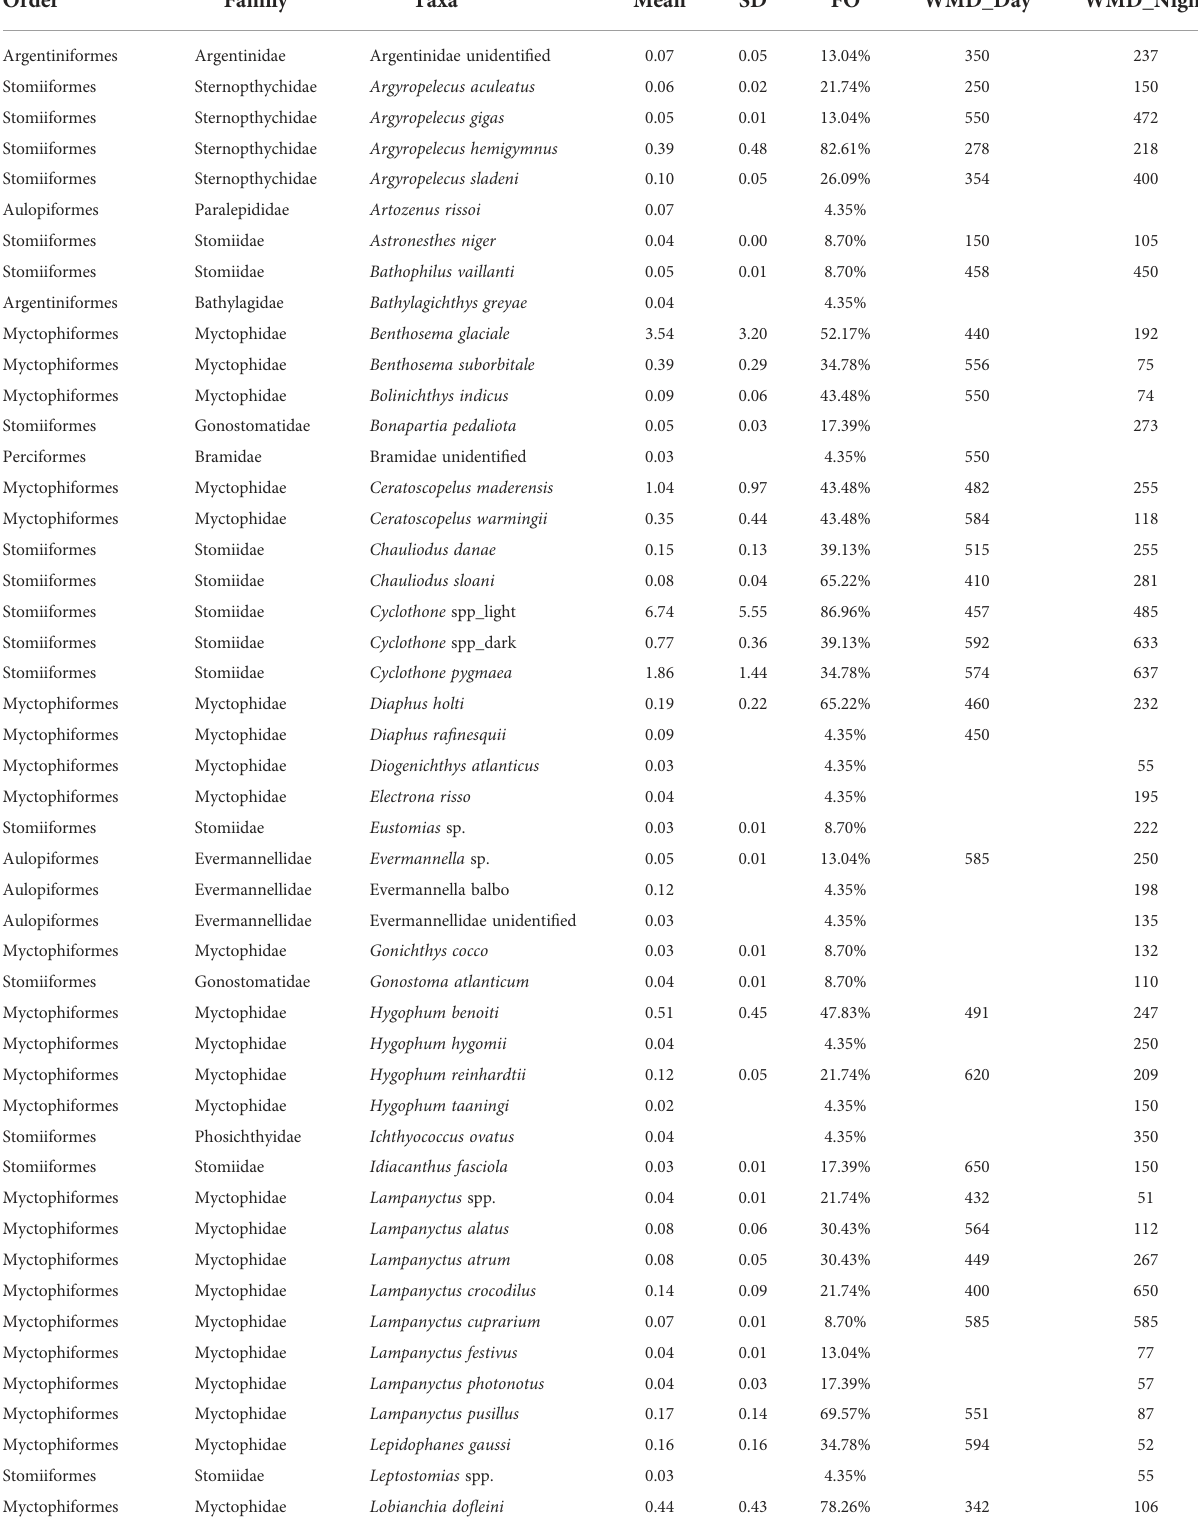
TABLE 2 Mesopelagic fi sh taxa collected during SUMMER